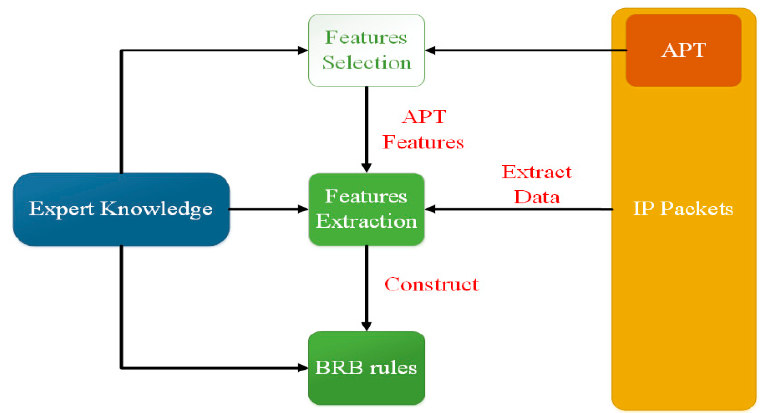
Figure 3. Process architecture.